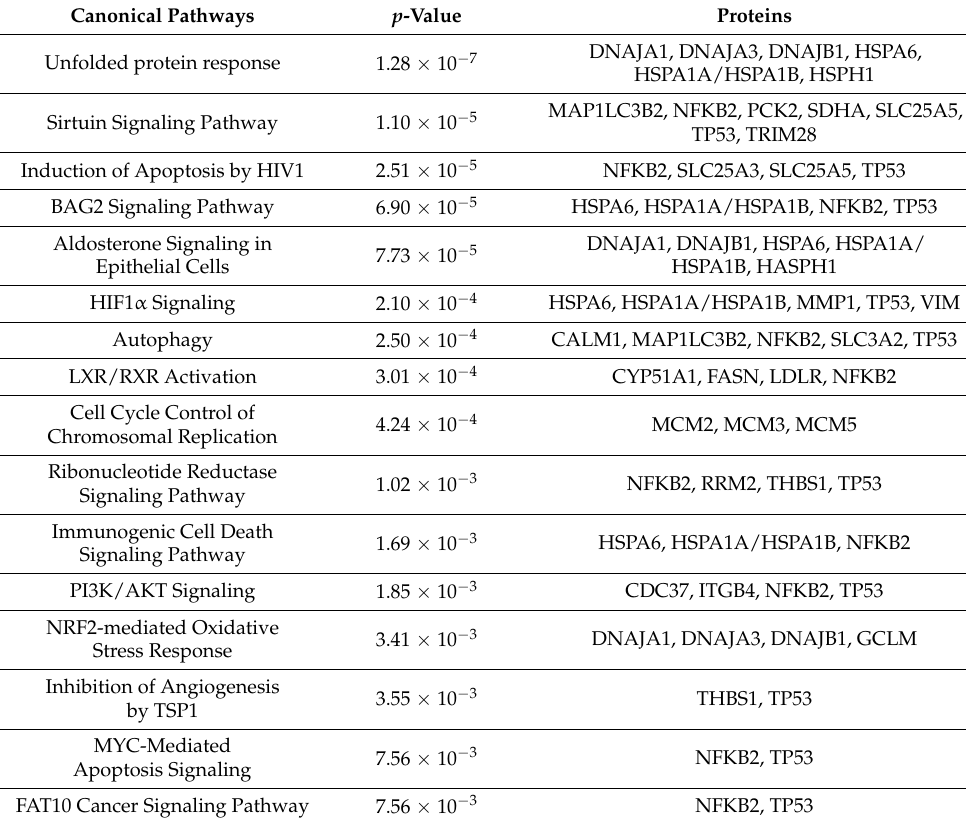
Table 4. Ingenuity canonical pathways associated with the differentially expressed proteins in CuHL2-treated